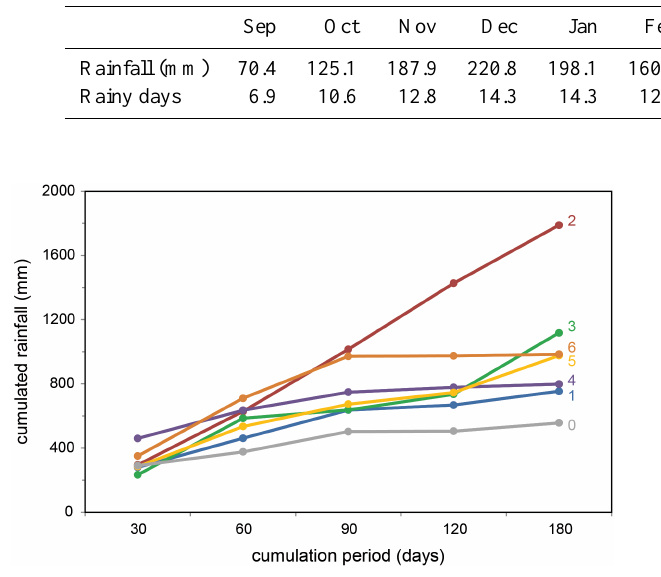
Figure 9. Cumulative daily rainfall (in mm) from 30 to 180 days be- fore landslide occurrences (Montalto Uffugo gauge). Numbers refer to the identification number (no.) in Table 2 (cf. first column).